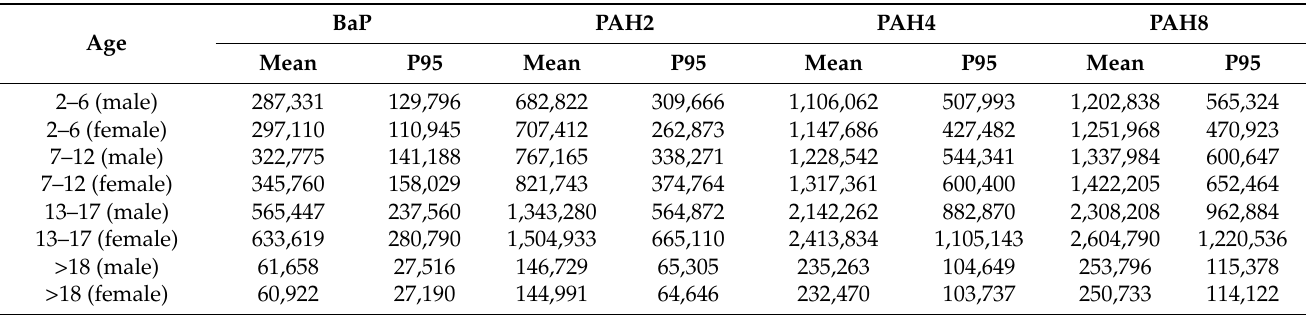
Table 7. MOEs for age/gender groups were calculated by dividing the lowest BMDL 10 values among the models with acceptable fits by the mean and 95th percentile estimates of dietary exposure to BaP, PAH2, PAH4, and